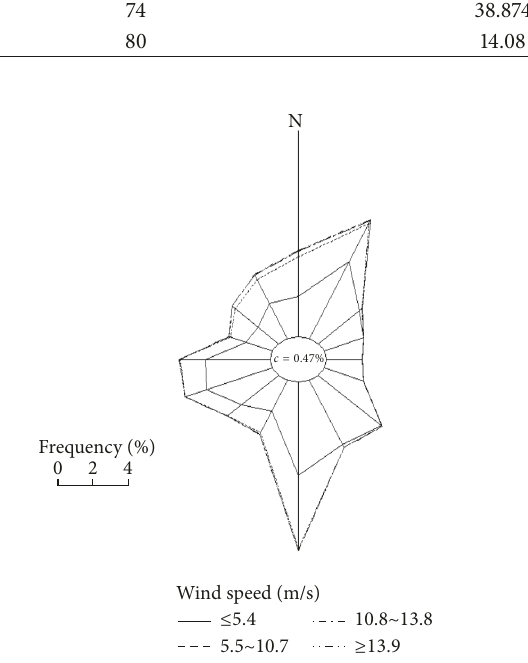
Figure 14: Wind rose diagram for Luanjiakou District in 2002– 2006. time, the initial minimum distinguishable spacing was 15 m, and the maximum distinguishable spacing was set as 100